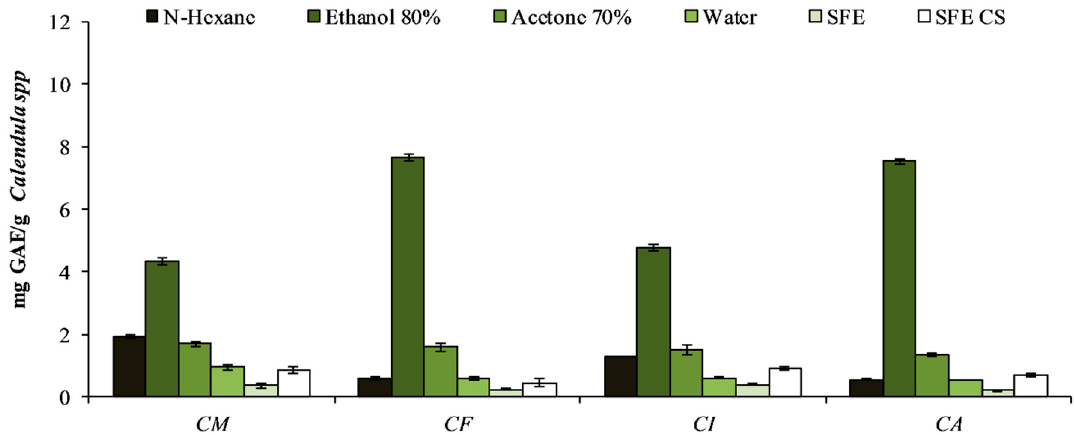
Figure 2. Total phenolic content (mg GAE/g) in extracts obtained from dried leaves of four Calendula taxa (CM: C. maritima ; CF: C. fulgida ; CI: C. hybrid ( maritima × fulgida ); CA: C. arvensis ), with different solvents (Results of the statistical analysis are shown in Supplementary Table S2).